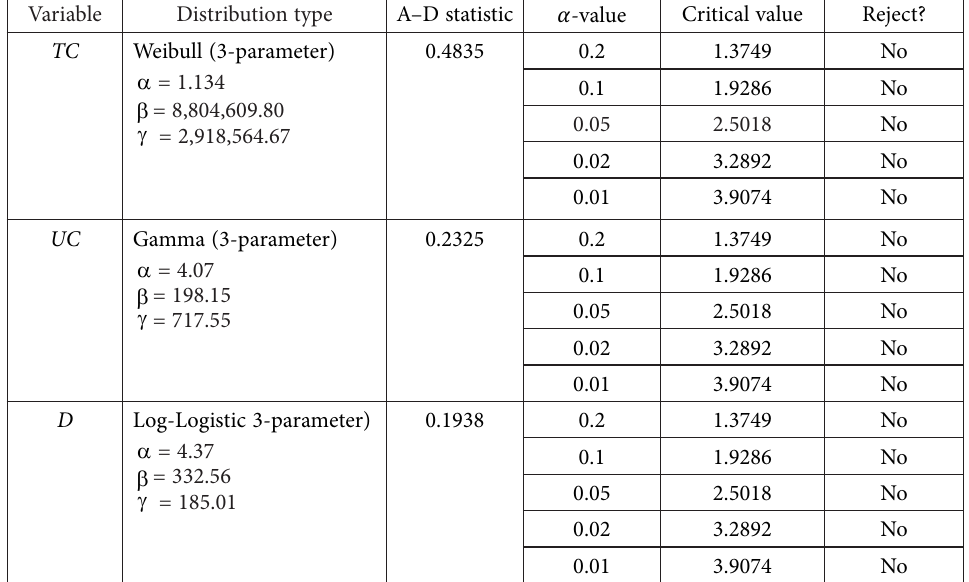
Table 2. Hypothesis test based on the A–D statistic